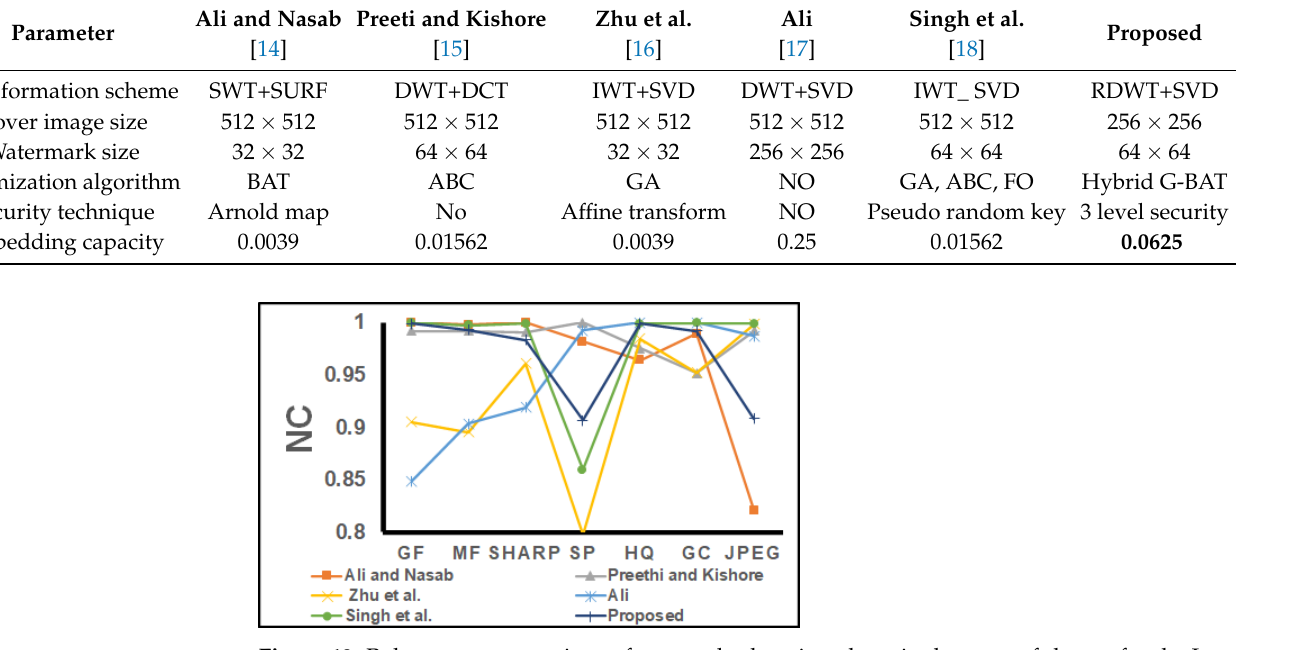
Figure 13. Robustness comparison of our method against those in the state-of-the-art for the Lena image under